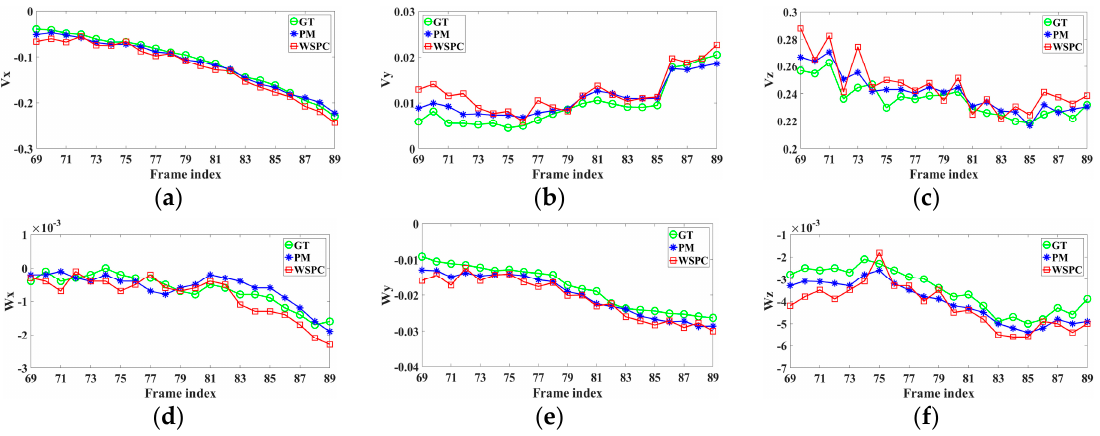
Figure 7. The results of ego-motion parameter estimation in scenario 2. ( a ) V x ; ( b ) V y ; ( c ) V z ; ( d ) W x ; ( e ) W y ; ( f ) W z .